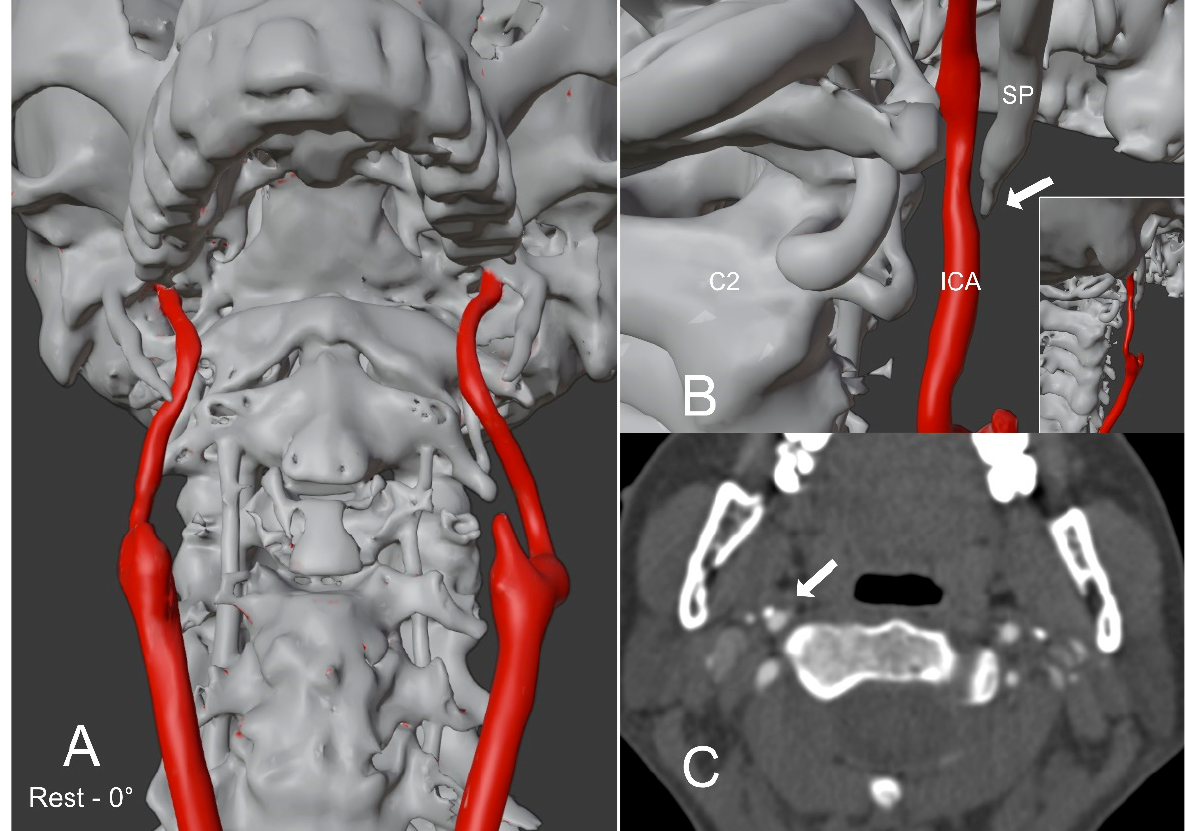
Figure 1. Patient with Eagle Syndrome in a rest position. ( A , B ) show a 3D reconstruction model of a patient with. The model was created from the rest position CTA of the head and neck. The right styloid process abuts the ipsilateral internal carotid artery (arrow in ( B )). The enclosed image in ( B ) represents a postero-lateral perspective with a zoomed-out view. ( C ) shows the CTA image of the styloid process abutting the ipsilateral internal carotid artery (arrow). SP = Styloid process; ICA = Internal carotid artery; C2 = C2 Vertebral body.